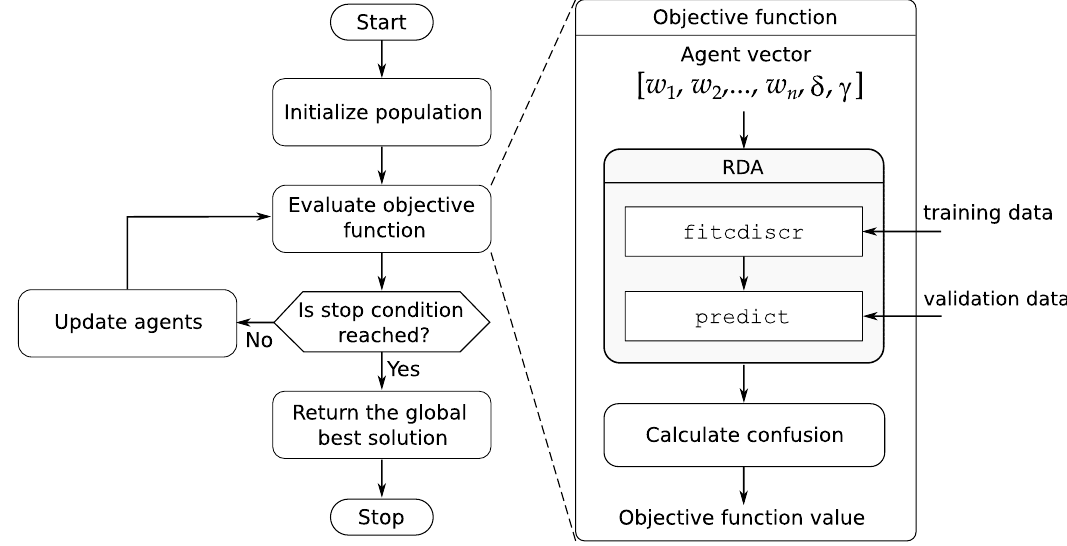
Figure 3. The idea of integration of swarm intelligence techniques with the